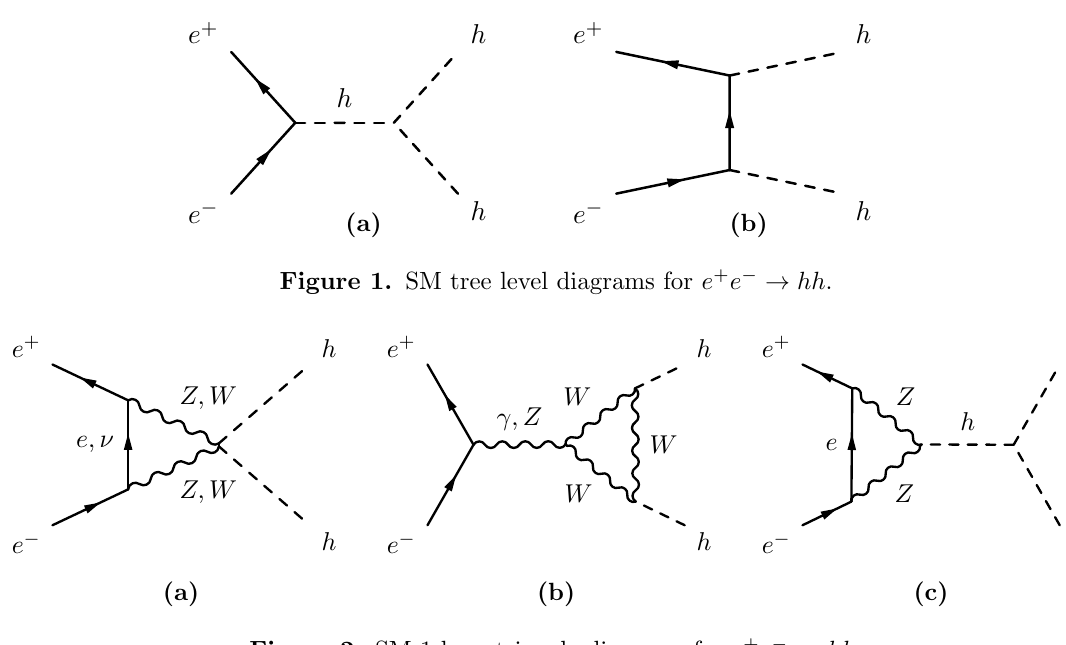
Figure 2. SM 1-loop triangle diagrams for e + e (cid:0) ! hh